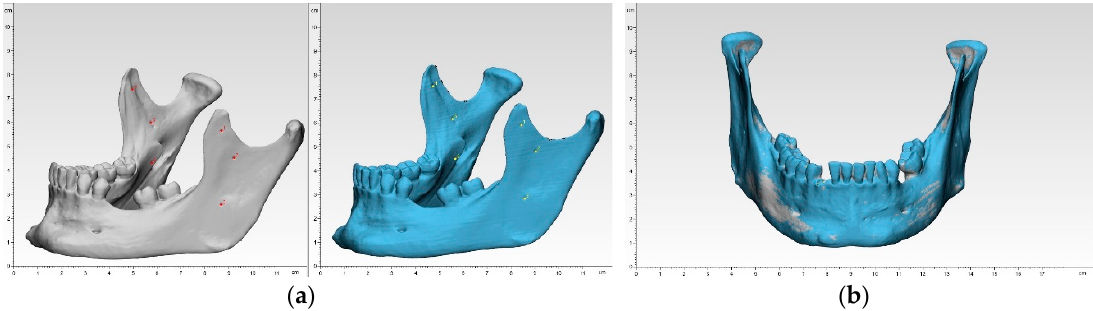
Figure 2. Registration process in 3-matic medical: ( a ) n-point registration; ( b ) after global registration.